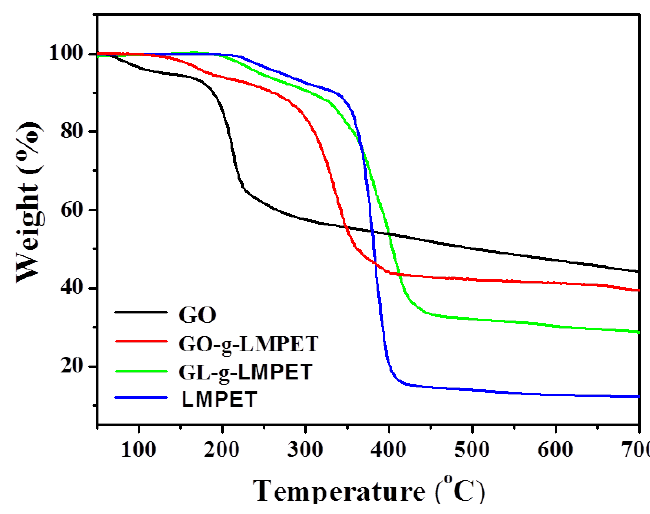
Figure 4. TGA profiles of GO, GO- g -LMPET, GL- g -LMPET, LMPET under N 2 atmosphere.